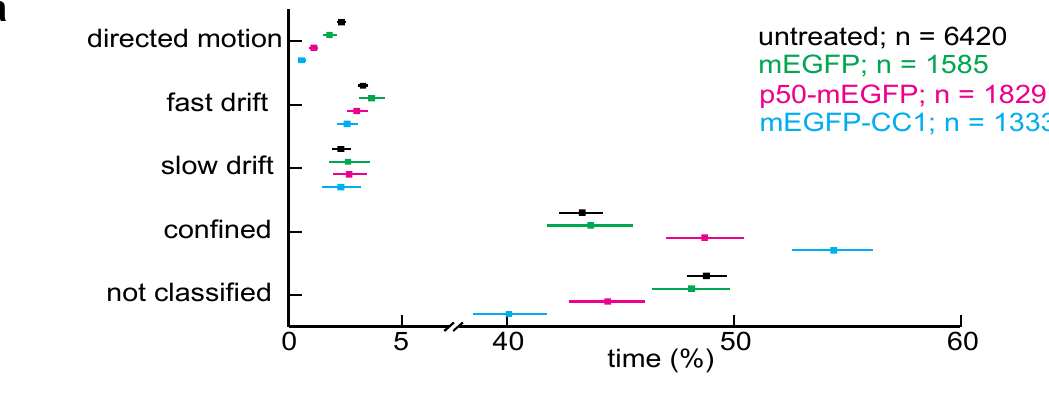
Figure 6. Dynactin supports long and fast microtubule-dependent motion runs. HeLa cells were seeded on glass cover slips and left untransfected or transiently transfected with mEGFP, p50-mEGFP or mEGFP-CC1 for 16 h. Cells were infected with HAdV2-atto565 and viral trajectories acquired 30–90 min p.i. with number of tracks (n). ( a ) The time that the viruses spent in certain motility types is shown as a fraction of total time with the median and the 95% confidence interval obtained by bootstrapping. ( b ) The data shown in (a) were grouped according to their directionality with the median and 95% confidence interval. ( c ) Representation of speed and run length histograms for DM runs. The frequency was normalized to the number of total DM for each condition. Note that the dataset for untreated cells is considerably larger than the datasets for the other conditions, and therefore the histogram for untreated cells appears smoother. Vertical red lines and red numbers with p-values in parentheses indicate the median for each dataset. Asterisks indicate medians that are significantly lower (*) than the median of untreated cells (p < 0.05). A threshold zone is indicated by a horizontal black line with the p-value representing the probability to draw a random sample (which has the size s as indicated) from the untreated dataset, which does not contain any value above the indicated threshold. c = number of cells; n = number of tracks; s = number of